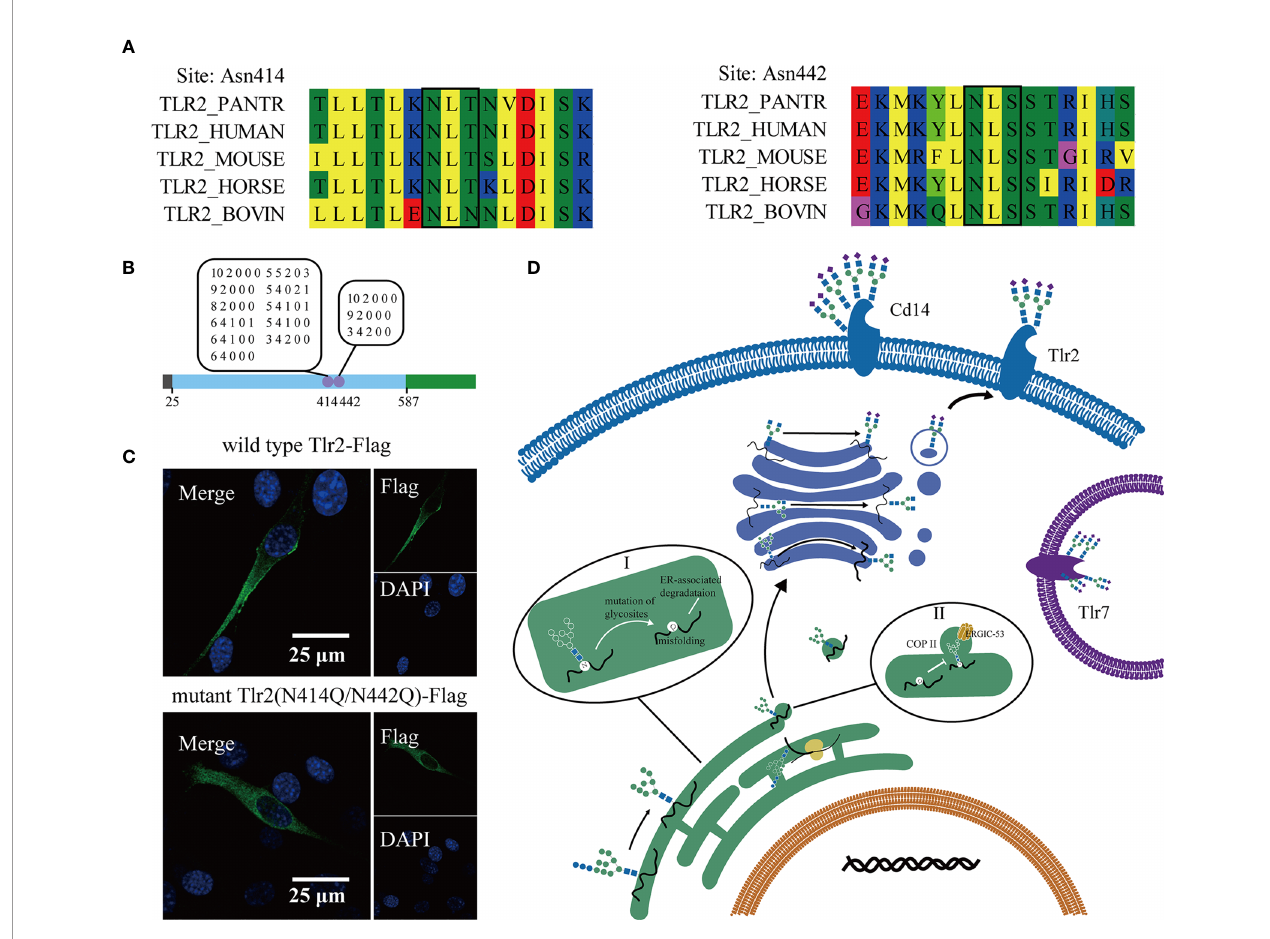
FIGURE 6 | Mutation of the glycosylation sites in Tlr2 altered its membrane location. Multiple sequence alignment of Tlr2 (N-glycosites) with other species (A) . Diagram of the Tlr2 sequence and the identi fi ed glycosylation sites and glycans (B) . Confocal image of 3T3 cells transfected with wild-type Tlr2 and glycosylation mutant Tlr2. Scale bar 25µm (C) . A schematic diagram of the subcellular location of the Toll-like pathway and vesicular transport; Aberrant glycosylation lead to misfolding of glycoprotein and ER associated degradation (I); ERGIC-53 bound to oligomannose oligosaccharide promote ER-Golgi apparatus COP II traf fi cking vesicle formation (II) (D)